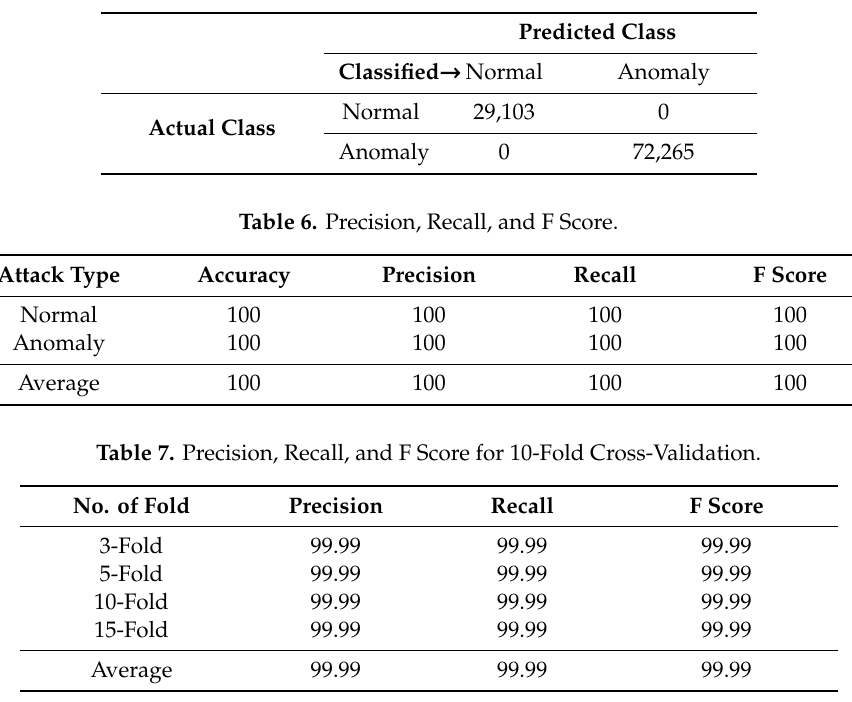
Table 5. Contingency Matrix Label.